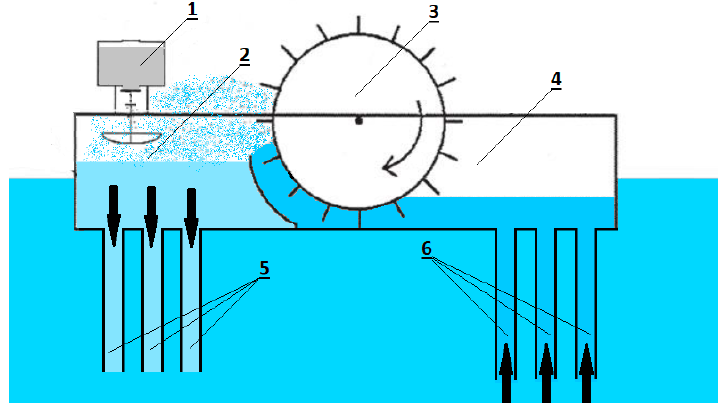
Figure 2. Scheme of the pulverization unit in the aerator. Note: 1, coagulant applicator; 2, pressuring chamber; 3, pulverizing circle; 4, suction chamber; 5, pressuring hoses; 6, suction hoses.